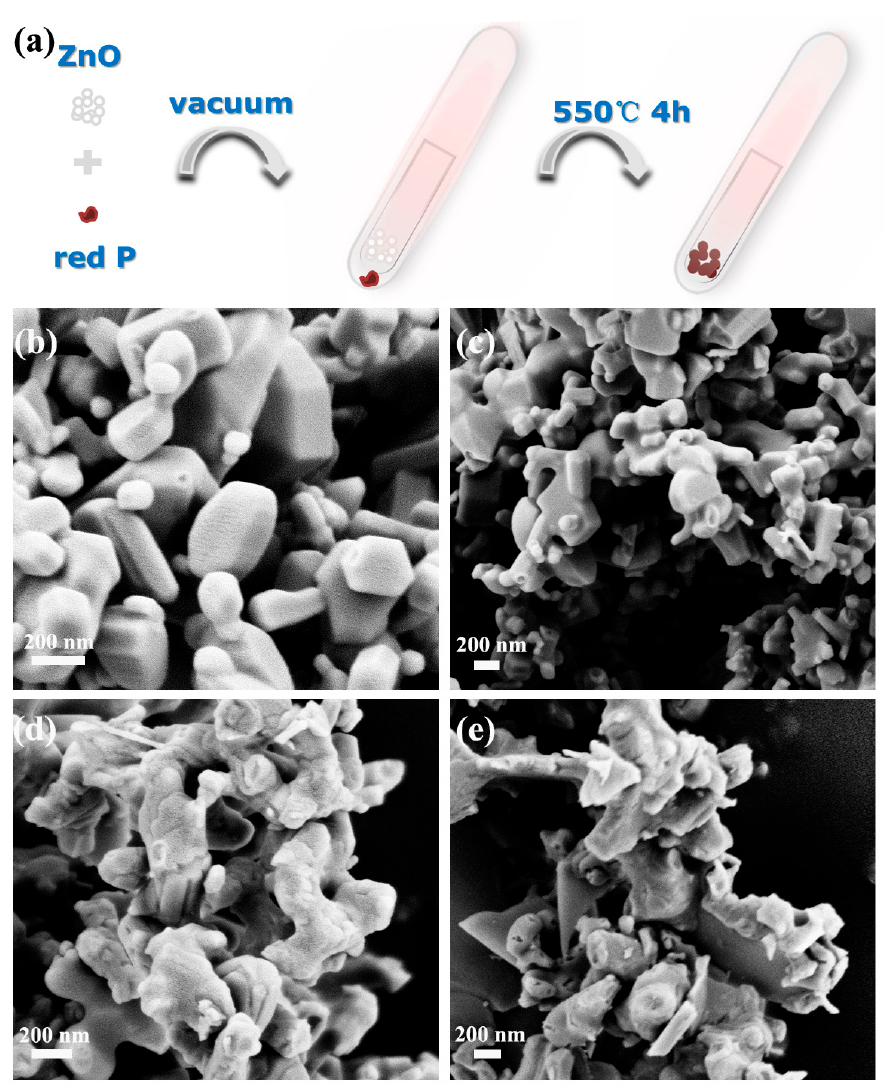
Figure 1. ( a ) Synthetic procedure for ZnO and red phosphorus (ZRP) heterostructure; ( b – e ) SEM images of ZnO-1, ZnO-5, ZnO-10 and ZnO-15.